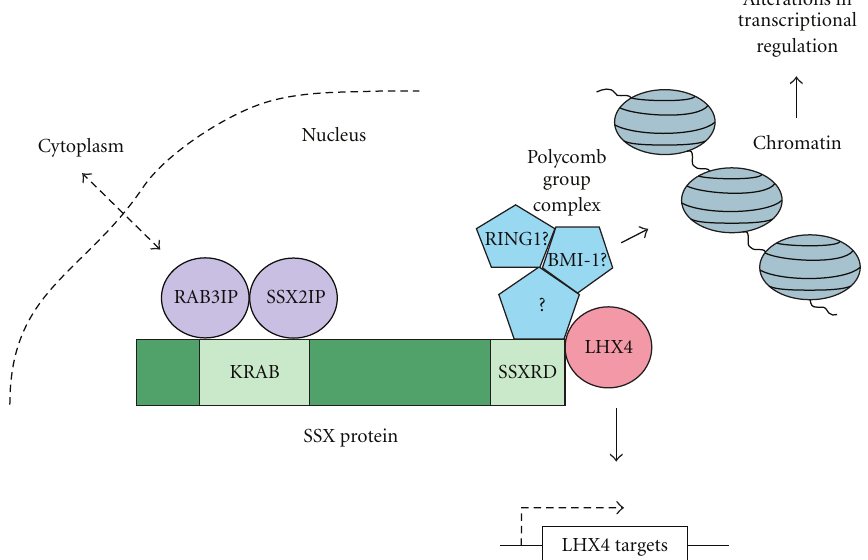
Figure 2: Functional interactions of the SSX proteins. The RAB3IP and SSX2IP protein interaction with the SSX KRAB domain and LHX4 and PcG protein interactions with the SSXRD domain are depicted. Dynamic intracellular and intranuclear interactions are